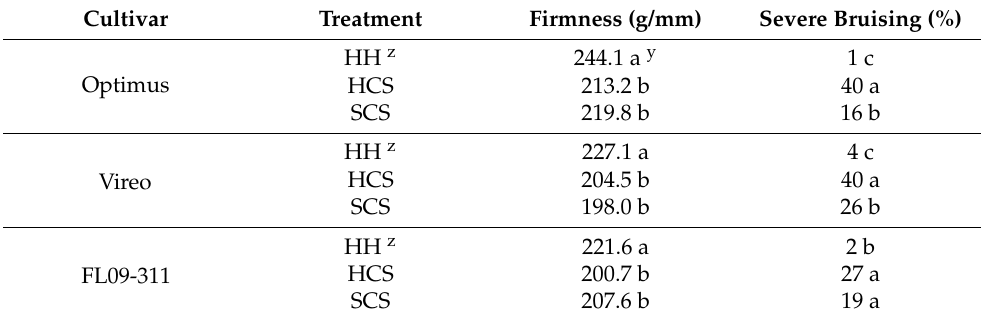
Table 3. Initial fruit firmness and severe internal bruising for “Optimus” and “Vireo” (Harvests 1 and 2 combined), and for “09-311” (Harvest 1 only), after hand harvest or mechanical harvest onto hard- or soft-catch surfaces. Fruits were sampled prior to commercial packing and held for 24 h at 24 ◦ C. Severe bruise: ≥ 20% sliced surface